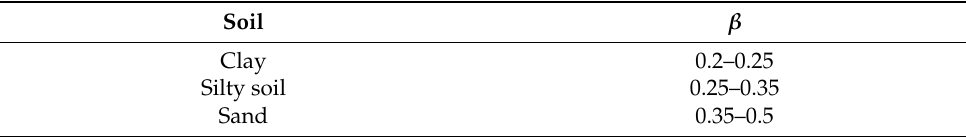
Table 1. The value range of empirical factor β